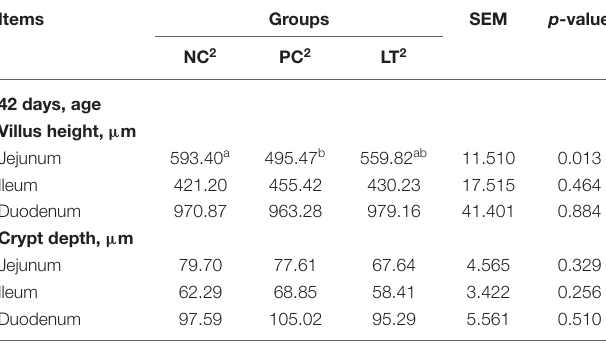
TABLE 3 | Effects of dietary L-theanine on meat quality of broilers under the oxidative stress 1 . Items